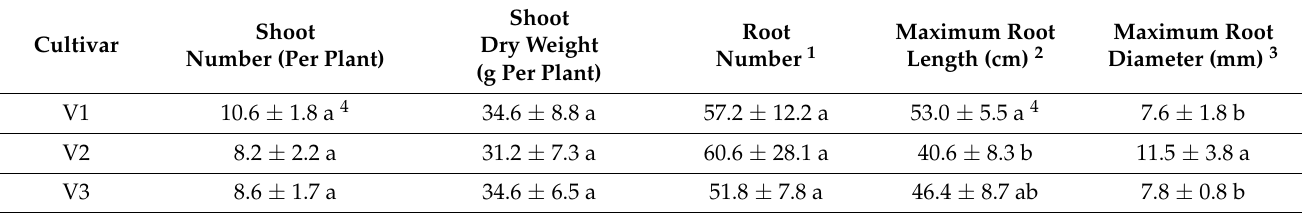
Table 2. Shoot number, shoot dry weight, root number, maximum root length, and maximum root diameter of three danshen cultivars grown in Mississippi, United States in